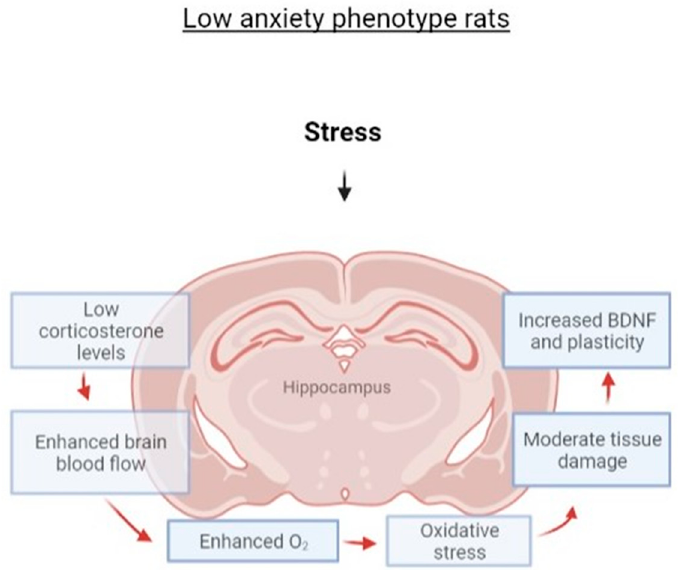
Figure 12. General scheme of hypothesized relations between stress exposure and hippocampal neurobiological characteristics.